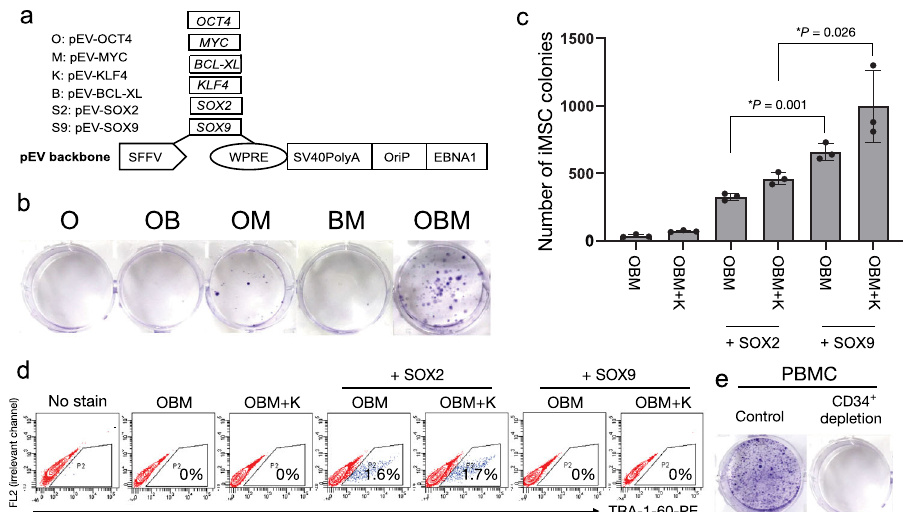
Fig. 1 OCT4 alone was insuf fi cient to direct reprogramming of human PBMCs into iMSCs. a Schematic diagram of the episomal vector plasmids. SFFV is the spleen focus-forming virus U3 promoter; WPRE, posttranscriptional regulatory element; SV40PolyA, polyadenylation signal from SV40 virus; OriP, EBV (Epstein – Barr virus) origin of replication; EBNA1, Epstein – Barr nuclear antigen 1. b Colony formation at day 14 after nucleofection with 2 × 10 6 PBMCs and maintenance in MSC culture conditions. c Reprogramming ef fi ciency with different combinations of reprogramming factors. Error bars indicate standard deviation. n = 3 biologically independent samples for each group. d Fluorescence-activated cell sorting (FACS) analysis of iMSCs 8 days after reprogramming with different factor combinations. SOX2 induced iPSCs generation (TRA-1-60 + cells). However, SOX9 did not induce detectable TRA-1- 60 + cells. e Colony formation at day 14 after nucleofection with 1 × 10 6 PBMCs (control) or CD34 + -depleted PBMCs followed by maintenance in MSC culture